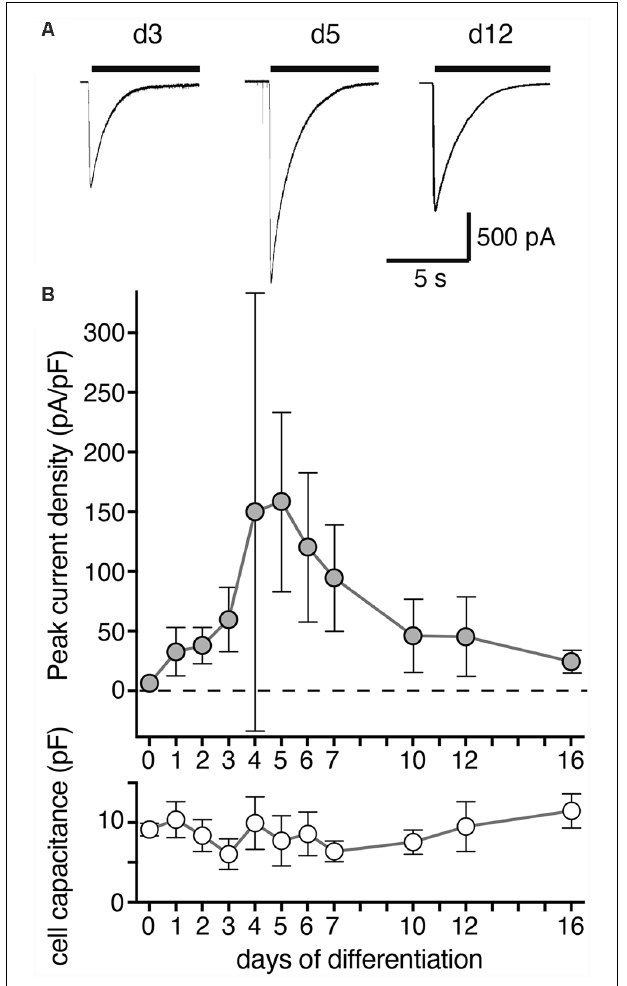
FIGURE 2 | Density of ASIC peak currents during differentiation of LUHMES cells into post-mitotic neurons. (A) Representative current traces from d3, d5 and d12. ASIC currents were elicited by a drop in pH from 7.4 to 6.0 and cells analyzed by whole cell patch-clamp. (B) Summary of current density and cell capacitance for different days of differentiation as indicated (mean ± SD; n = 4–12 from two independent experiments). Note that the current density on d4 was highly variable and not normally distributed with some cells having a small density like on d3 and others a large density like on d5. Current amplitude ranged from 36 to 3,603 pA for individual cells on different days of differentiation.